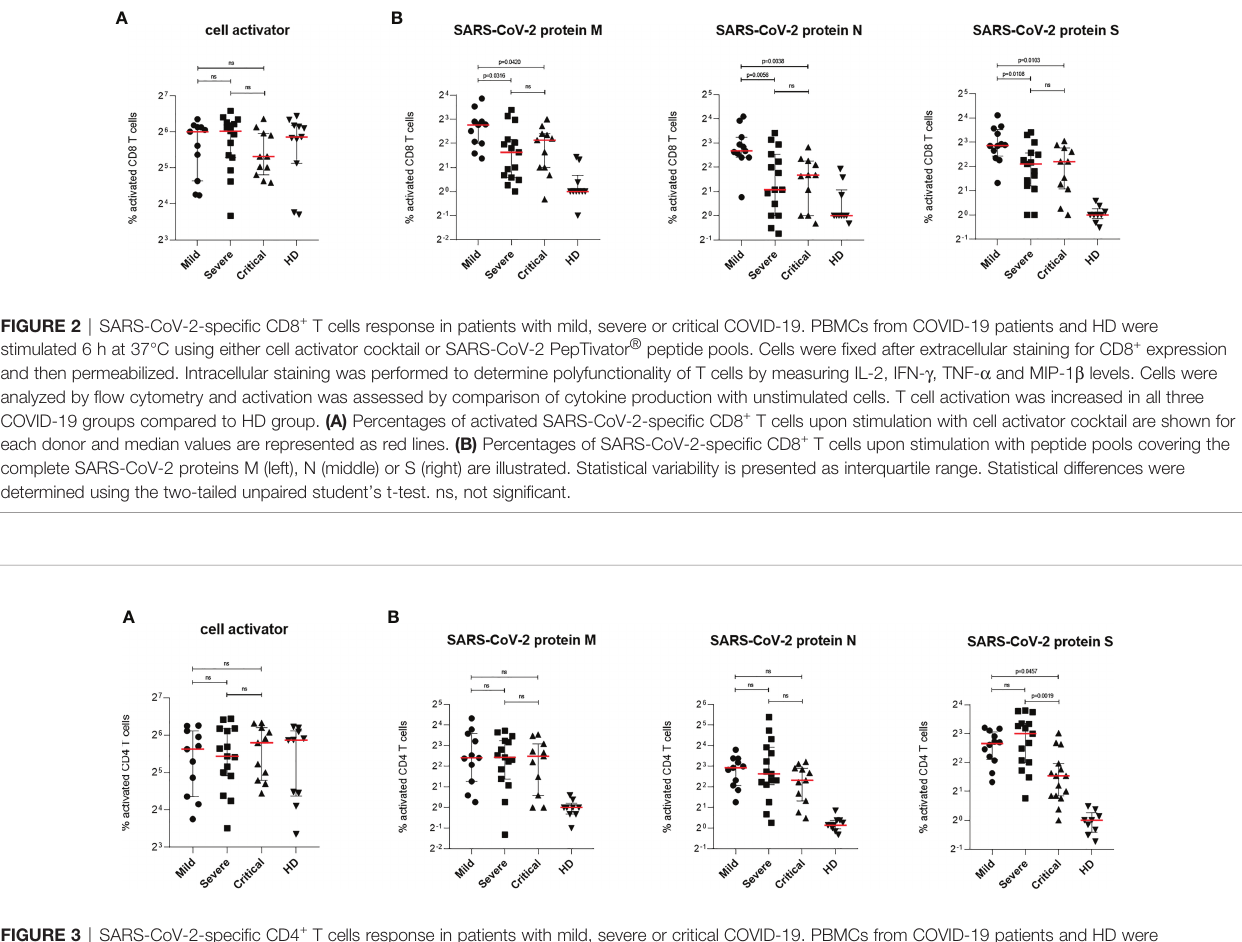
analyzing activation of the CD4 + T cell fraction in all patient PBMCs ( Figure 3A ). Stimulation of CD4 + T lymphocytes with protein M or N of SARS-CoV-2 revealed no signi fi cant changes in cell activation between patients with mild, severe or critical COVID-19 ( Figure 3B ). In contrast, stimulation with protein S showed a signi fi cantly higher activation of SARS-CoV-2 speci fi c T cells in patients with mild compared to patients with critical COVID-19 as well as between patients with severe and critical disease progression ( Figure 3B , right). No signi fi cant differences in SARS-CoV-2-speci fi c T cell activation were found between patients with mild and severe COVID-19 ( Figure 3B , right). Cells from healthy donors showed only background or no activation upon stimulation with SARS-CoV-2 speci fi c peptide pools ( Figure 3B ).